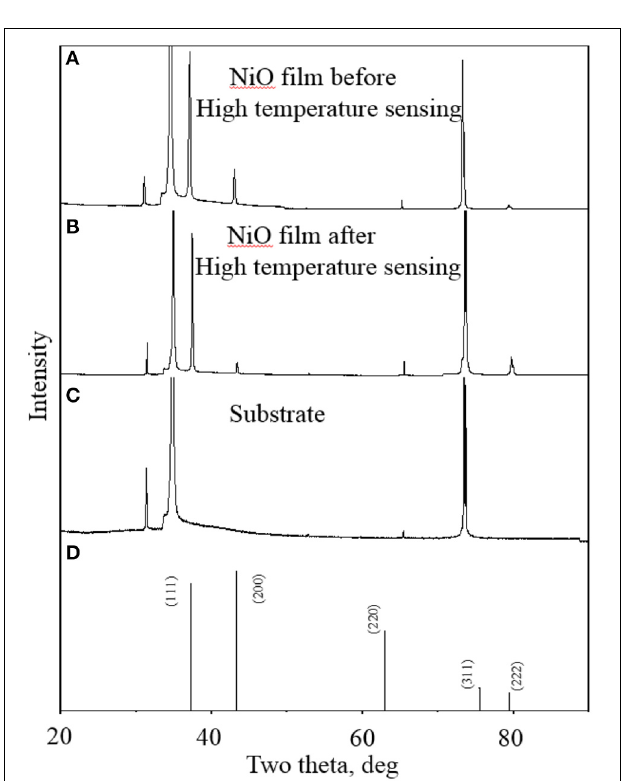
FIGURE 4 | XRD patterns of NiO nanoparticle thin films (sintered at 1100 ◦ C) before (A) and after (B) high temperature oxygen sensing experiments; (C) XRD pattern of YSZ substrate; and (D) XRD pattern of standard pattern of